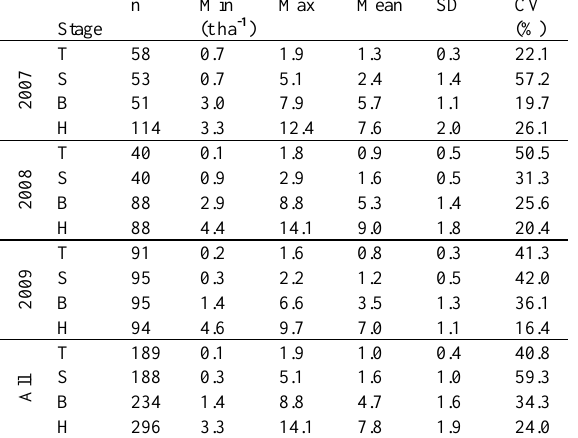
Table 2. Descriptive statistics of AGB (dry matter) on the experimental fields for different growth stages and years; with SD = standard deviation and CV = coefficient of variation